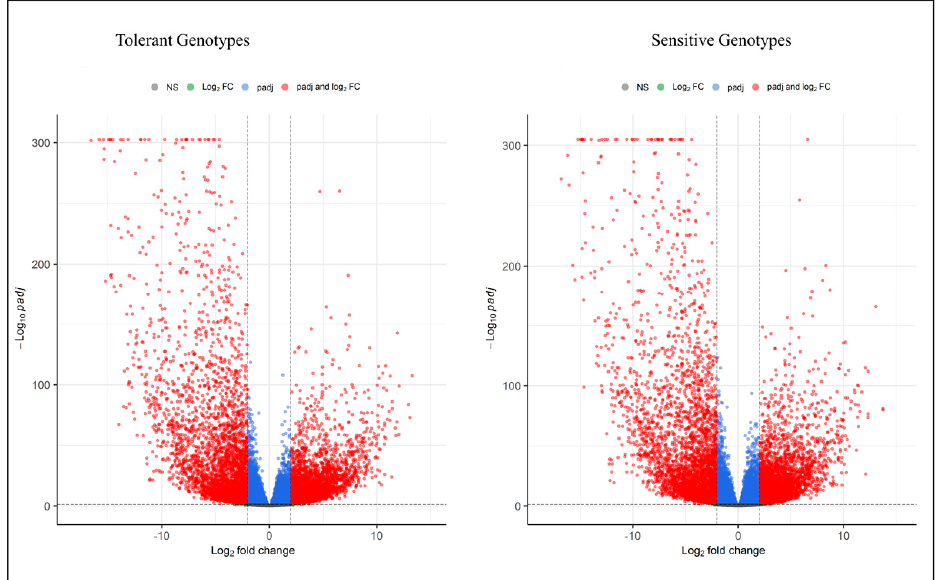
Figure 3. Volcano plots illustrate the up and downregulation of DEGs in tolerant and sensitive gen- otypes. The red color indicates the up and down regulation of DEGs based on the log2 fold change and padj <